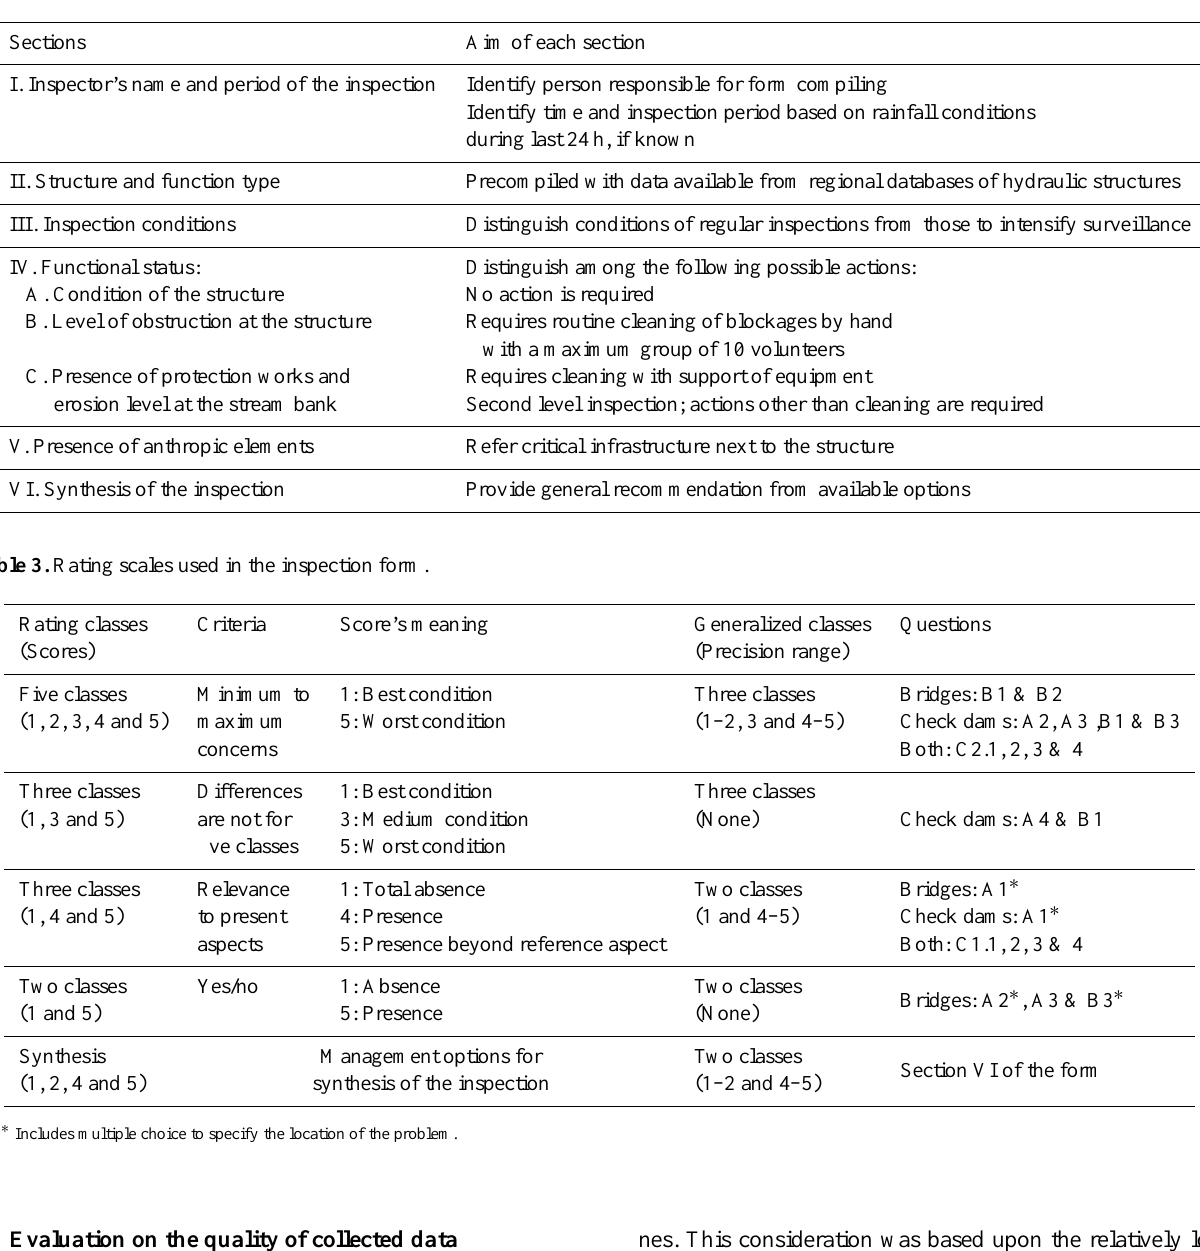
Table 2. Form’s layout for bridges and check dams.